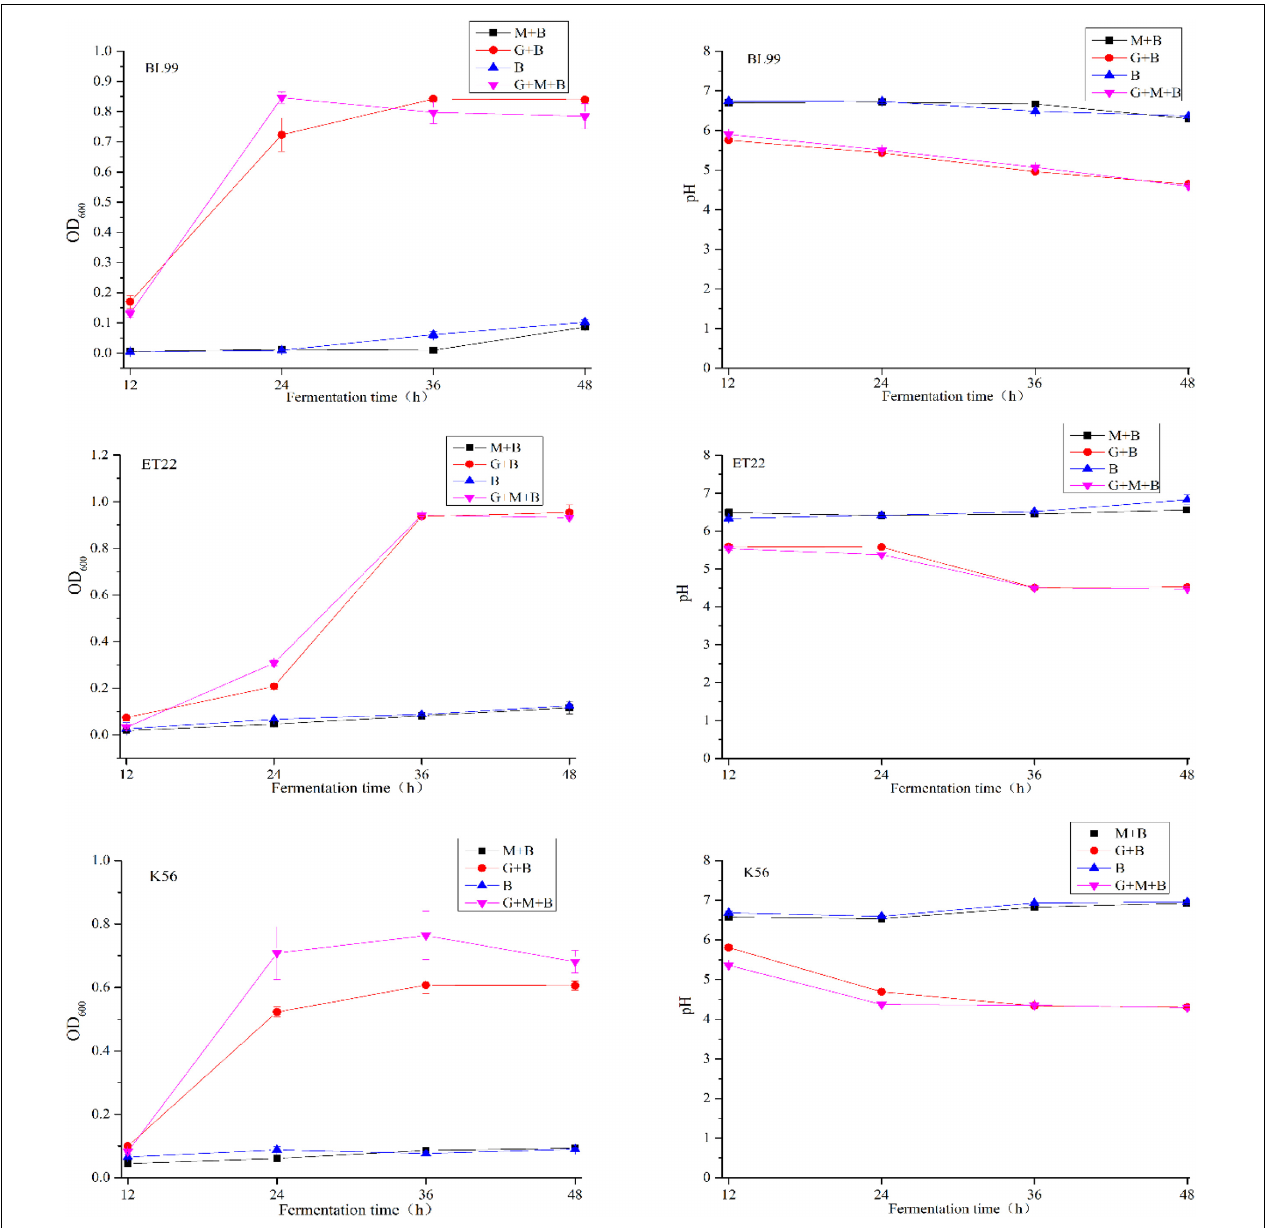
FIGURE 1 | The OD 600 and pH values of BL-99, ET-22, and K56 strains were measured within 12, 24, 36, and 48 h of fermentation culture. The four different media are basal medium (B), basal medium containing 1% glucose (G+B), basal medium containing 0.3% gastrointestinal mucosal protein (M+B), basal medium containing 1% glucose, and 0.3% gastrointestinal mucosal protein